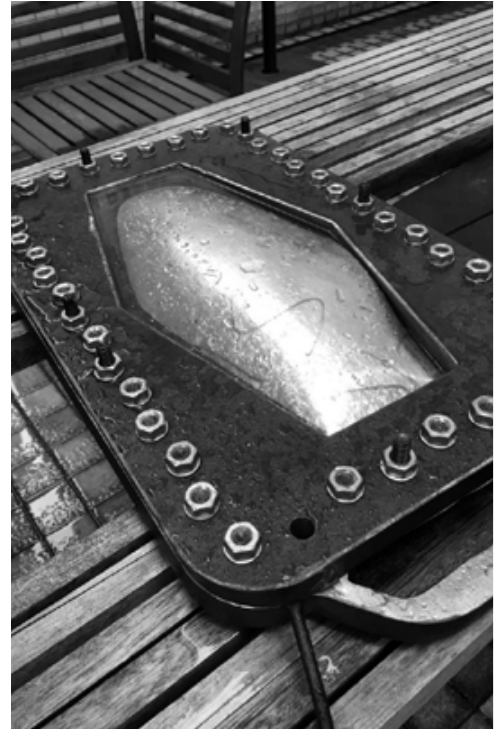
Figure 3 (left): Current pressure forming rig, with a hexagon- shaped forming die. Source: author. Figure 4 (right): Resultant hexagonal formed shell. As Ayres pointed out, one distinctive quality of the pressure forming process is that deformation amount is at the user’s discretion up to the limit of the material, allowing labour discretion into the fabrication and design process. Note the deformation of the sheet near the through-holes for bolting the forming rig together. These make flanging for demountable panels difficult, making elimination of this fixing method a